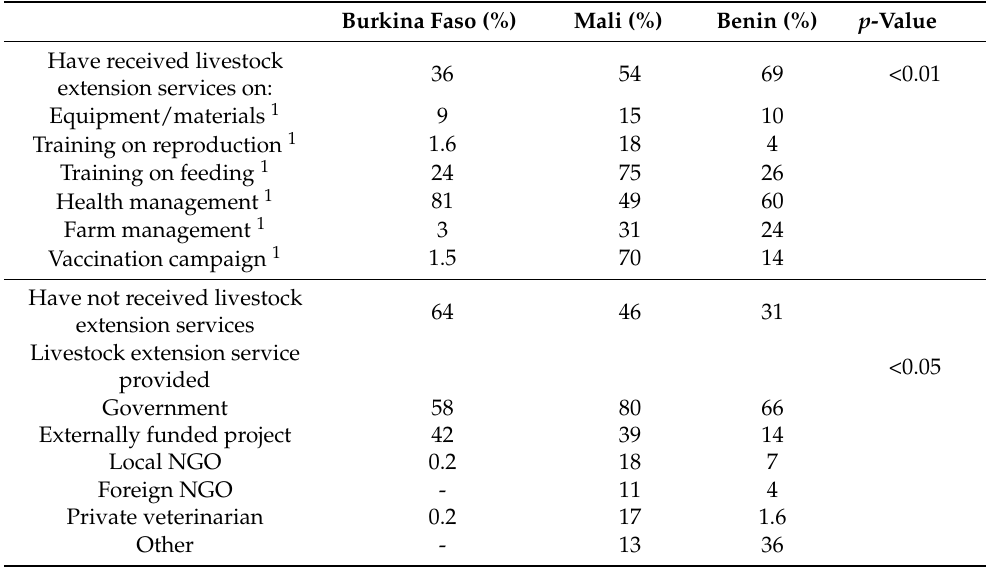
Table 2. Proportion of respondents in Burkina Faso, Mali, and Benin that reported receiving livestock extension services, and the service